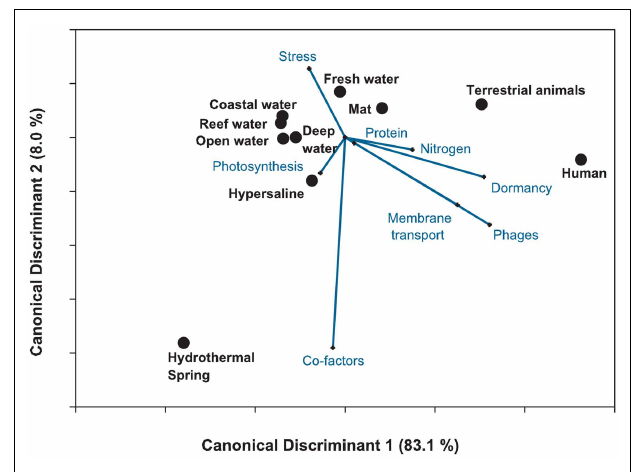
FIGURE 9 | Canonical discriminant analysis of the 212 metagenomes using the top eight variables identified from the random forest analysis. The plot shows the separation in the host-associated microbial communities and the free-living communities.The analysis explained 91% of the variance, suggesting that metagenomes can be discriminated by the metabolic potential. Lines depict the h-plot of important metabolic processes and the points are the centroid or mean for the 10